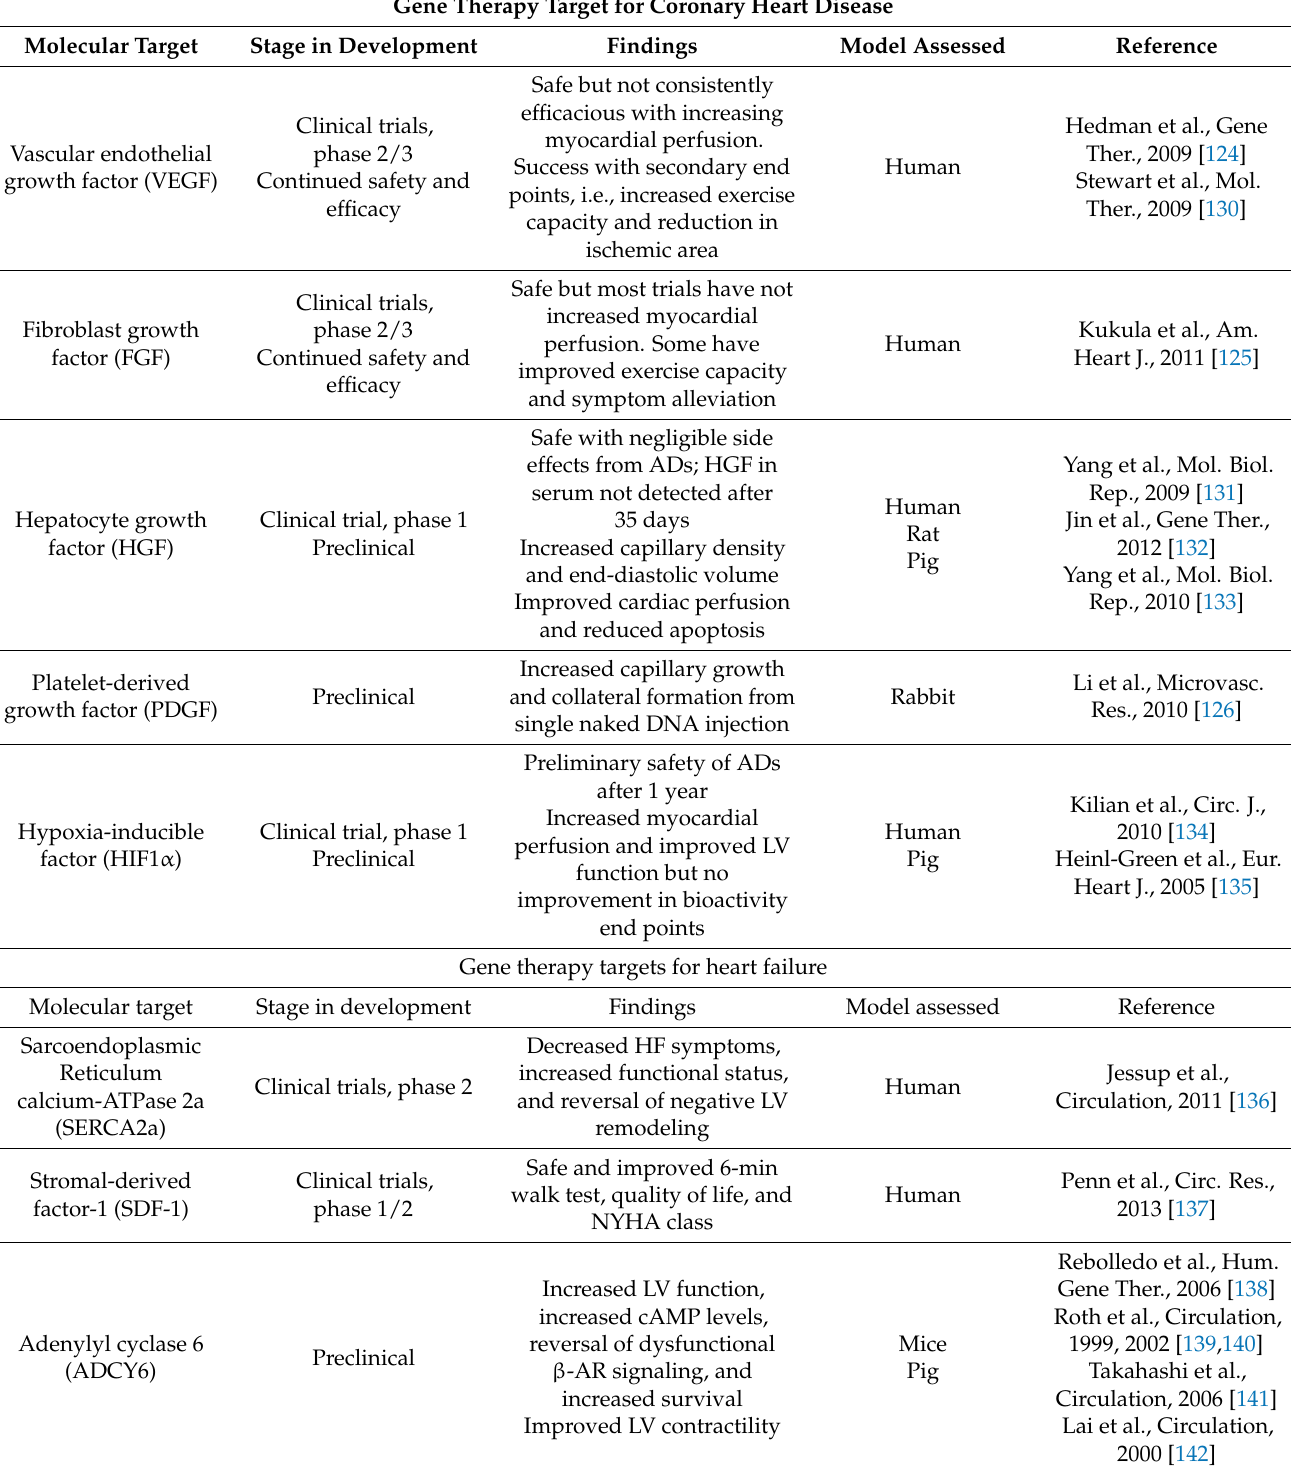
Table 3. Possible gene therapy target for CAD and HF